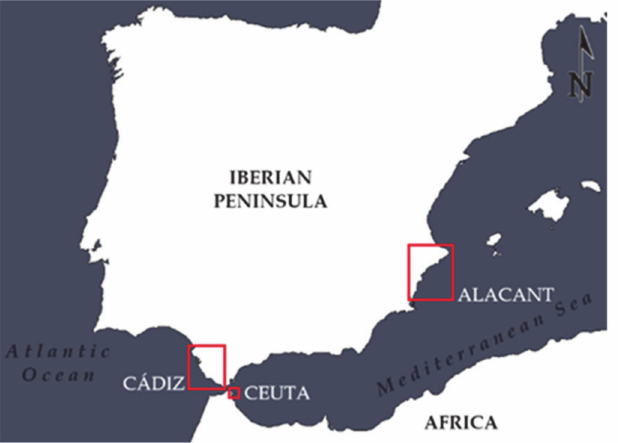
Figure 1. Study area: the provinces of C á diz, Ceuta and Alacant (Southern